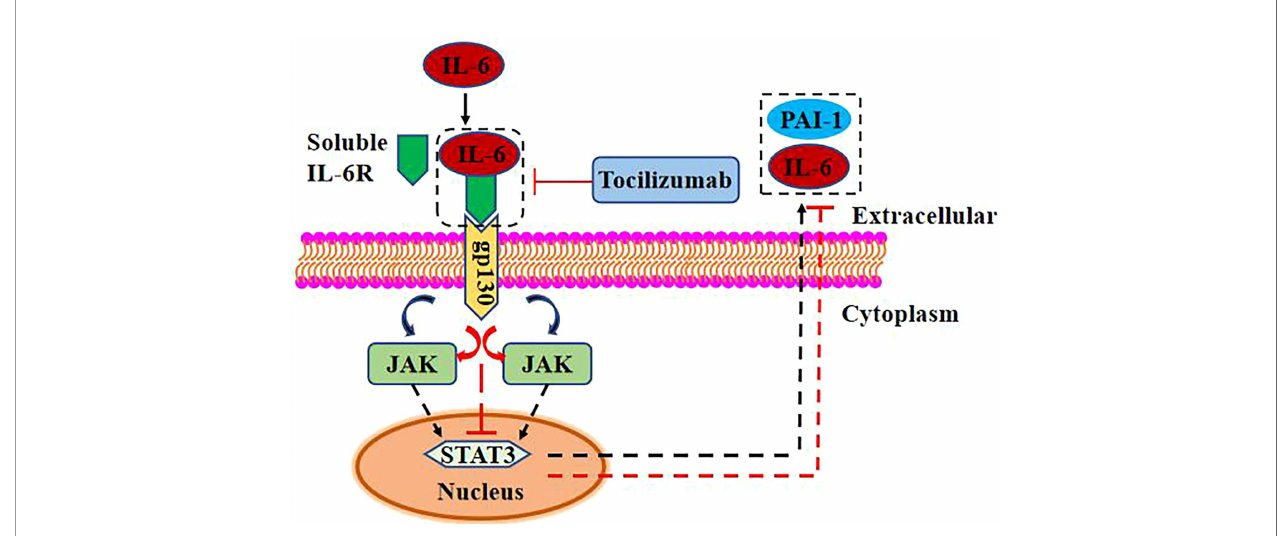
FIGURE 3 | IL-6 promotes PAI-1 expression via transsignaling. High concentration of IL-6 combined with soluble IL-6R can activate the JAK/STAT3 signal pathway through gp130 andupregulate the expression of PAI-1 and IL-6. TCZ can reduce the expression of PAI-1 and IL-6 byinhibitingthe binding of IL-6 and soluble